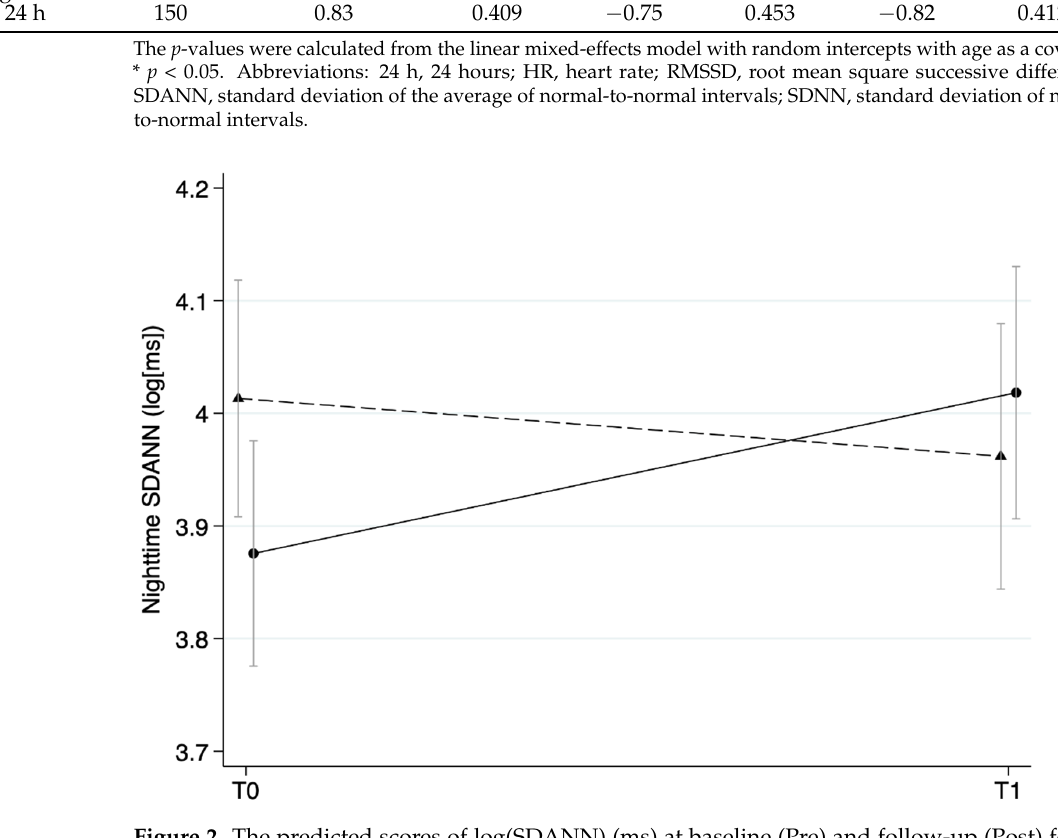
Figure 2. The predicted scores of log(SDANN) (ms) at baseline (Pre) and follow-up (Post) for the intervention and control groups (mean ±